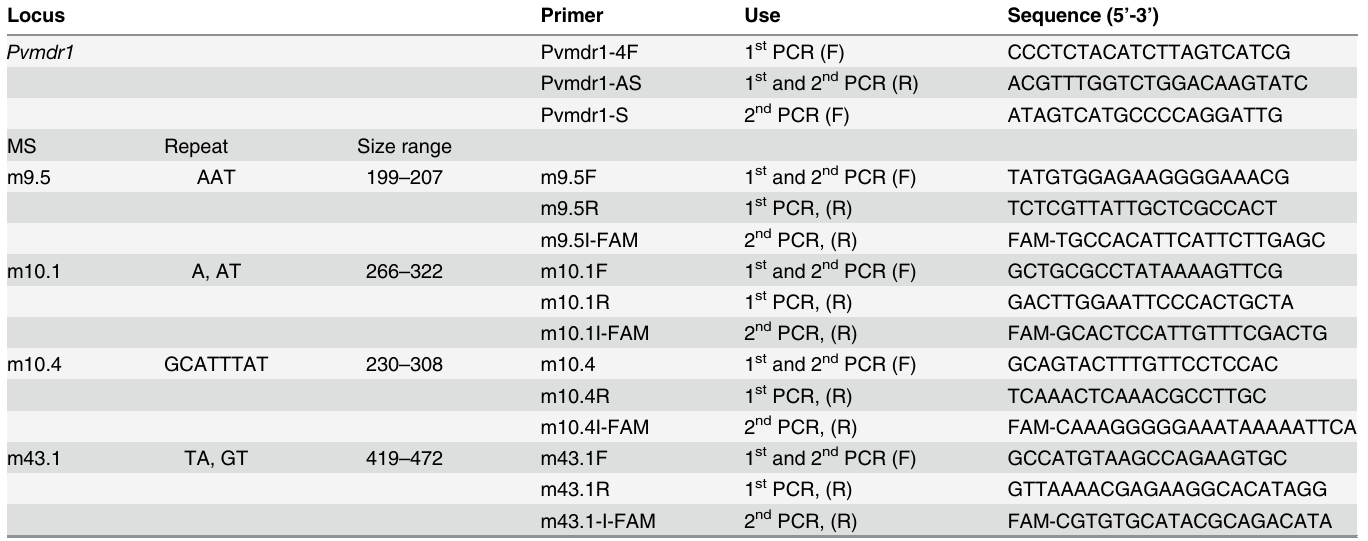
Table 1. Primers for amplification and sequencing of the Pvmdr1 gene and four flanking polymorphic repeat regions.